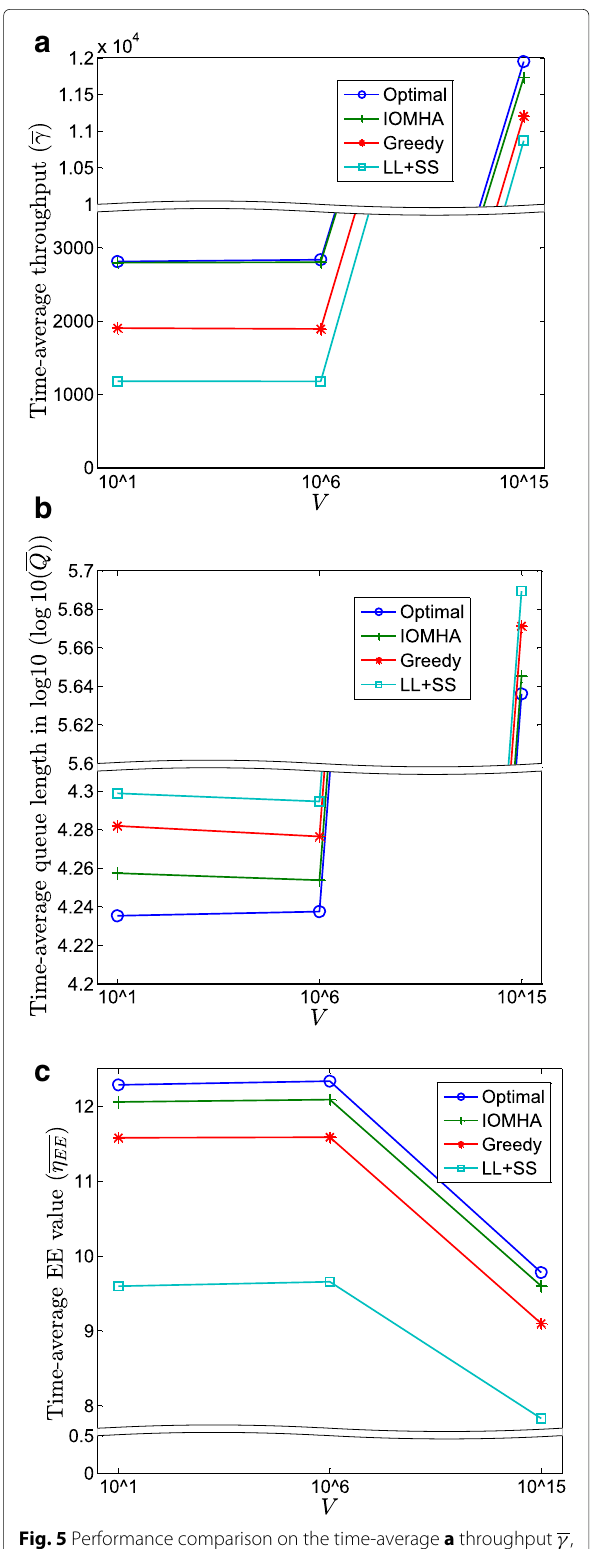
Fig. 5 Performance comparison on the time-average a throughput γ , b data queue length Q , and c energy efficiency η EE that are optimally obtained and resulted from IOMHA, Greedy, and LL+SS,